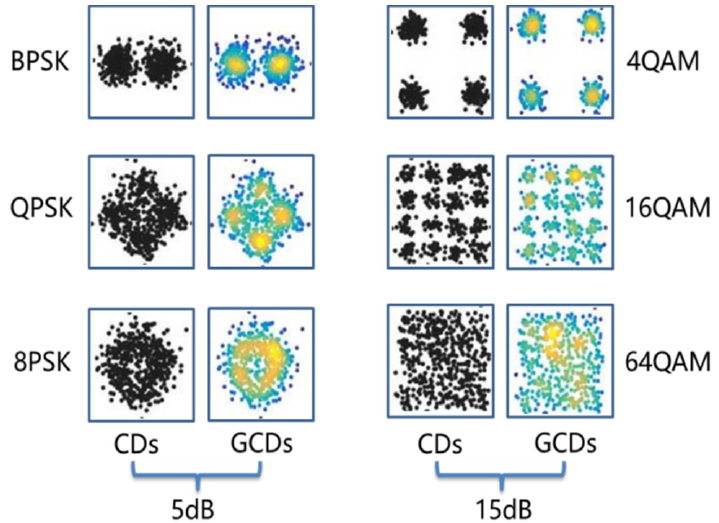
Figure 1. Grid-like constellation diagrams of MPSK ( left ) and MQAM ( right ).